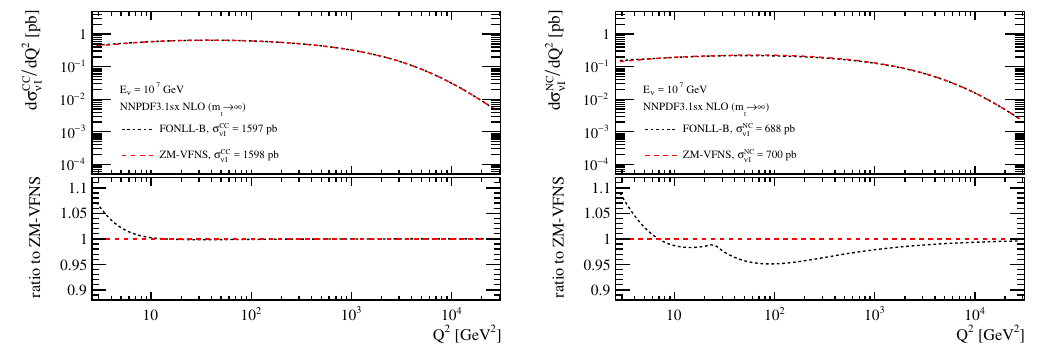
Figure 4 . Comparison between the FONLL and ZM-VFN heavy-quark mass schemes at NLO for the calculation of the single-di(cid:11)erential cross-section d (cid:27) (cid:23)I = d Q 2 , eq. (2.5), for CC (left) and NC (right) scattering at E (cid:23) = 10 7 GeV. In both cases the limit m t of the top